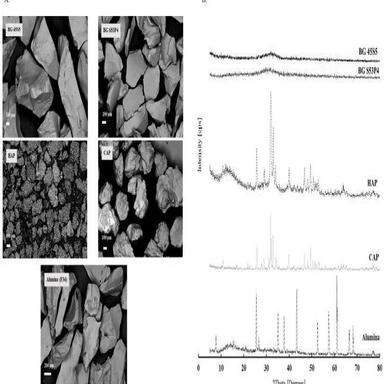
(a) SEM images of the studied materials as received/before dissolution (b) XRD patterns of the studied materials. For abbreviations, see 1a.